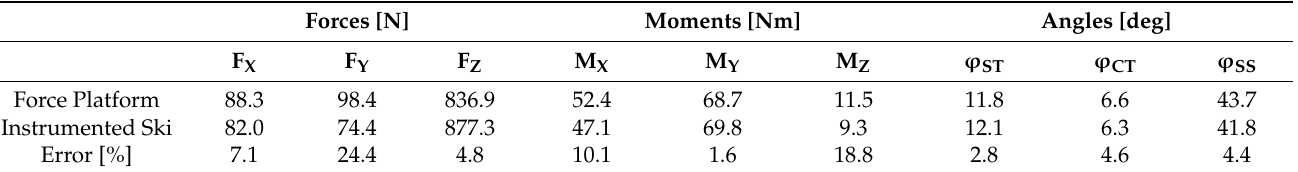
Table 1. Peak values of resultant GRF during system validation.